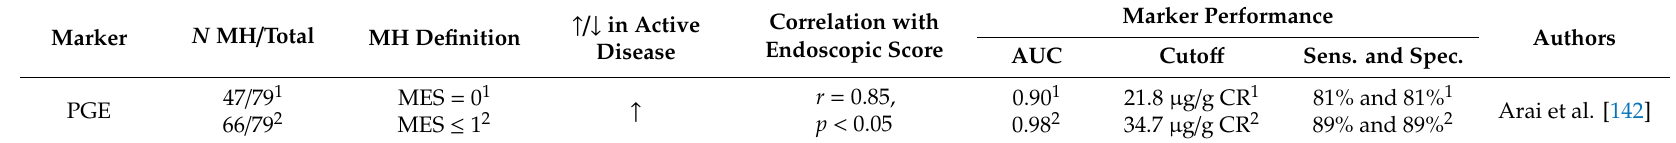
Table 10. Diagnostic performance of urine-based markers in MH detection for ulcerative